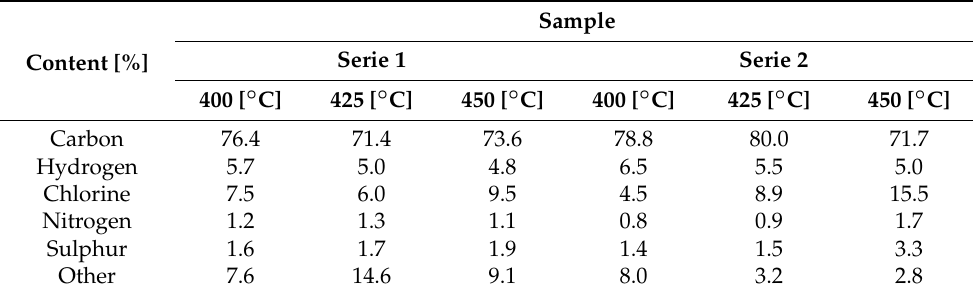
Figure 3. Post-pyrolysis metallic fraction obtained after the separation of the solid fraction. Table 3. Results of char’s chemical analyses. Serie 1—pre-consumer waste. Serie 2—post-consumer